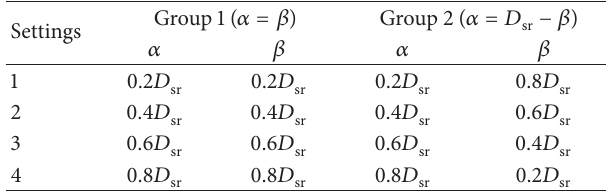
Table 1: Overall settings of 𝛼 and 𝛽 .